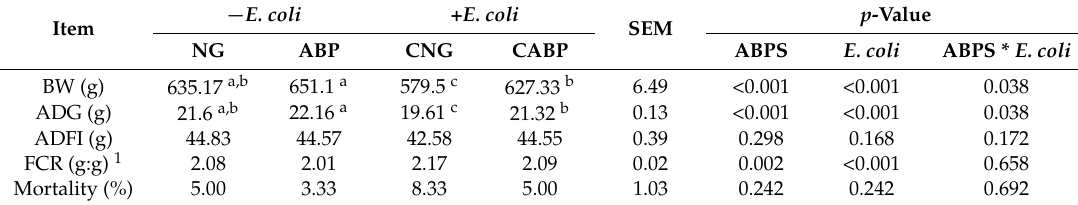
Table 2. Effects of ABPS and E. coli challenge on growth performance of yellow-feathered broilers.